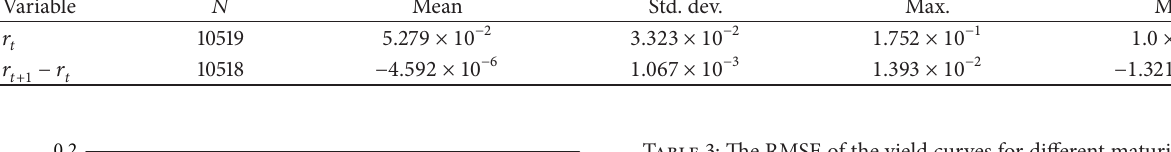
Table 3: The RMSE of the yield curves for different maturity times under Assumptions